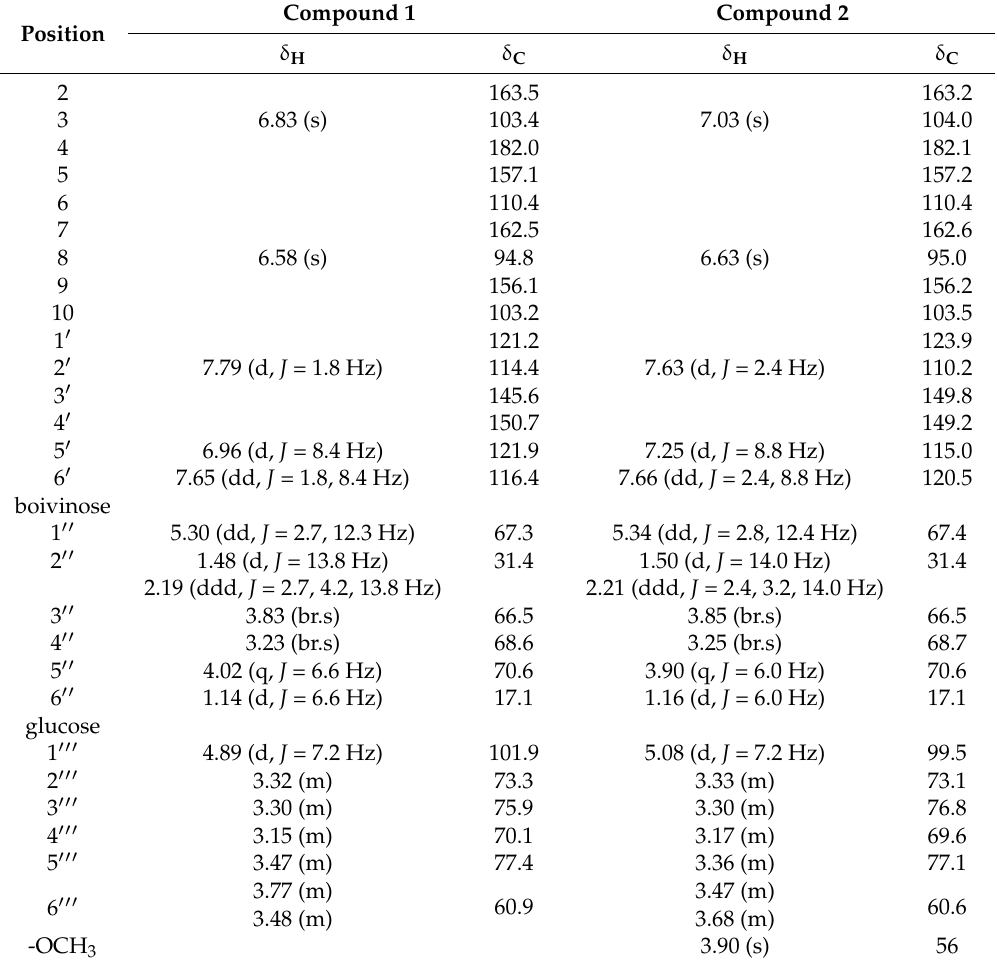
Table 1. 1 H-NMR (400 MHz) and 13 C-NMR (100 MHz) data for compound 1 and 2 in DMSO- d 6 .